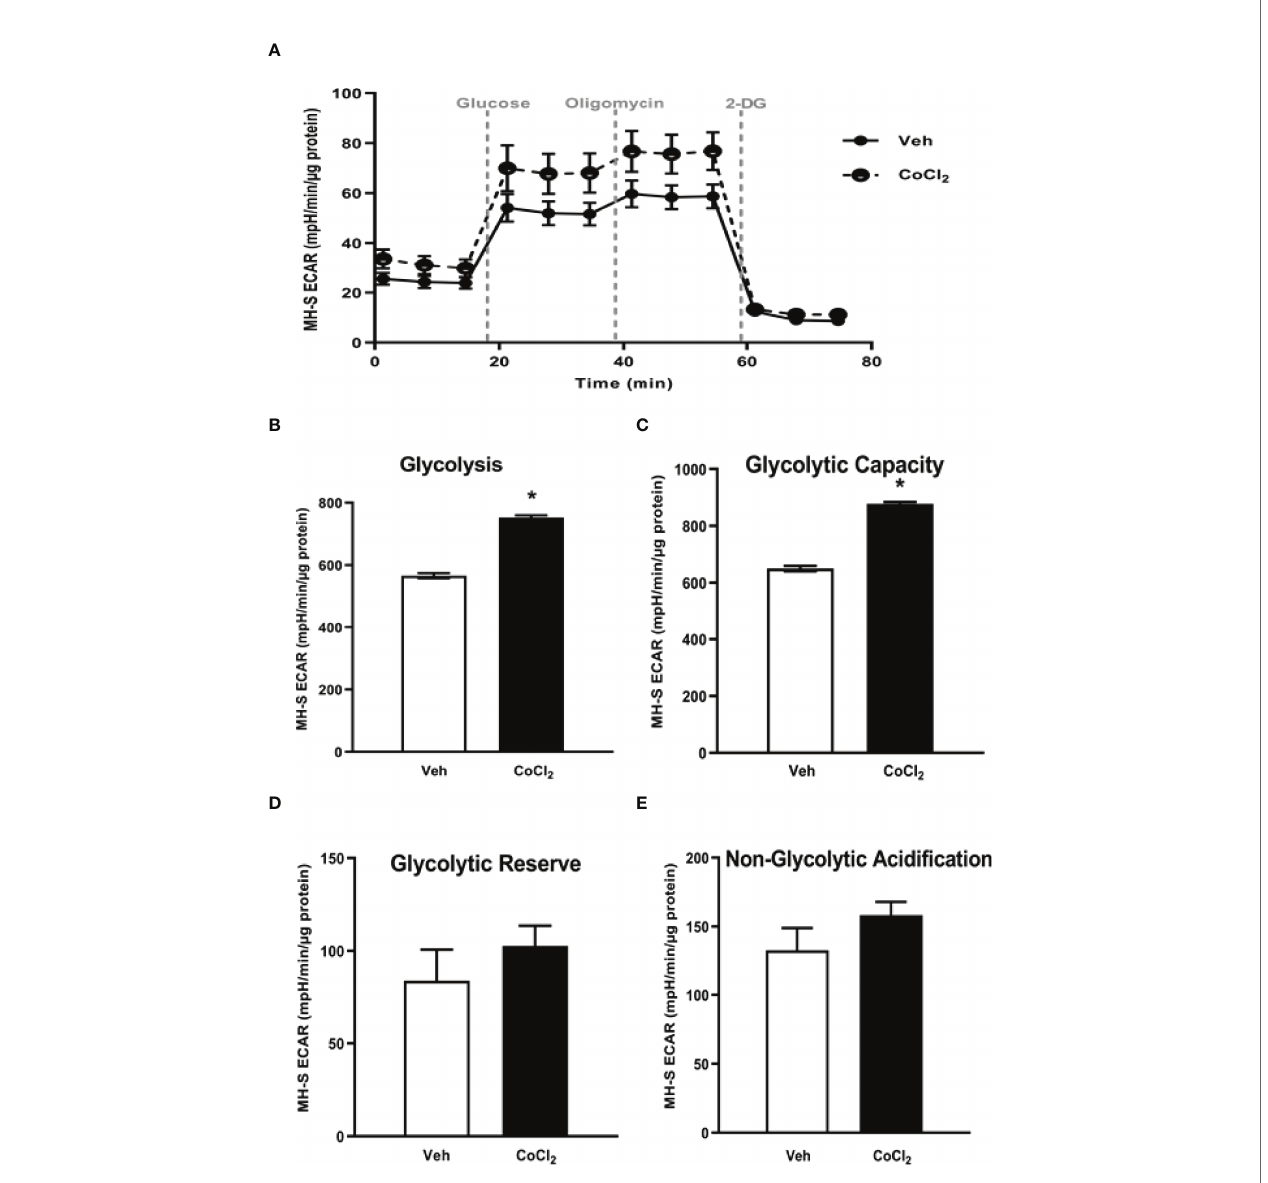
FIGURE 5 | Stabilization of HIF-1 a in vitro via cobalt chloride mimics EtOH-mediated derangements in MH-S. MH-S were exposed to either vehicle (Veh) or cobalt chloride (CoCl 2 , 25 m M) for 4 hours. Extracellular acidi fi cation rates (ECAR) were measured in response to sequential injections of glucose (saturating concentration of glucose to promote glycolysis), oligomycin (ATP synthase inhibitor), and 2-deoxy-glucose (2-DG; a glucose analog that inhibits glycolysis) using an extracellular fl ux analyzer. ECAR from glycolytic pro fi ling, normalized to protein levels, and are expressed as mean ± SEM (A) , glycolysis (B) , glycolytic capacity (C) , glycolytic reserve (D) , and non-glycolytic acidi fi cation (E) are expressed as mean ± SEM, relative to vehicle (n = 6). * p < 0.05 versus